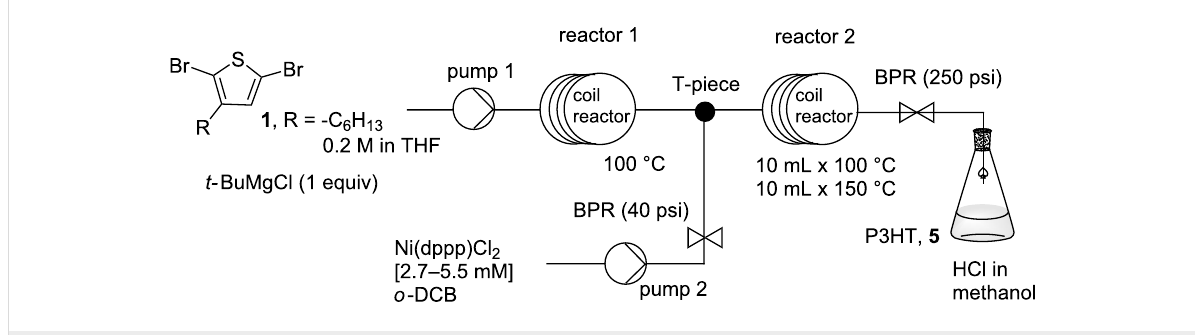
both 2,5-dibromo-3-hexylthiophene ( 1 ) and the tert -butylmag- nesium chloride (0.2 M in THF) were allowed to react at 100 °C with a retention time of 20 min in reactor coil 1.